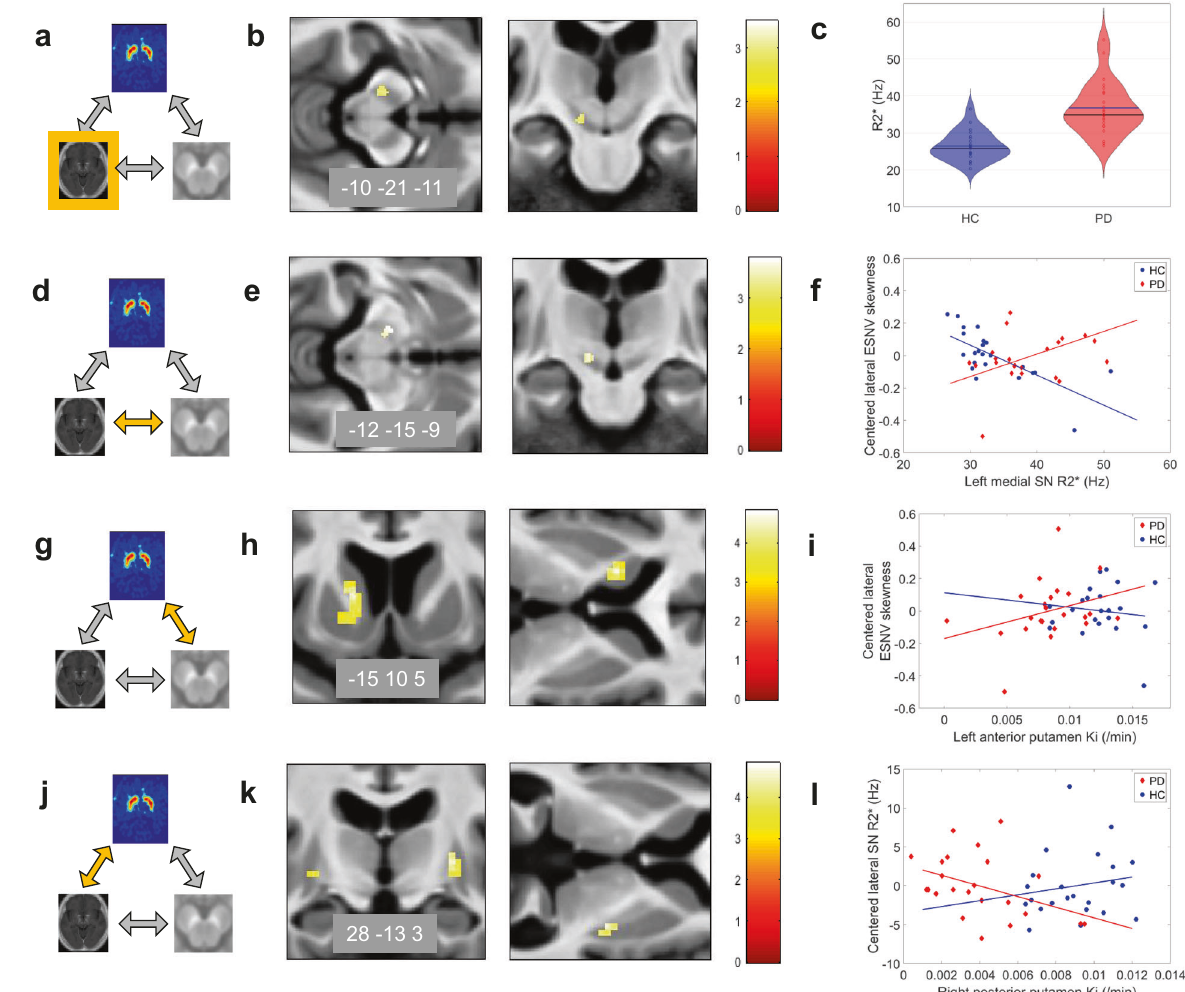
Fig. 4 Relationships between NM-sensitive MRI, R2*, and [18F]DOPA PET changes in Parkinson ’ s disease. a – c R2* changes in Parkinson ’ s disease. Main effect of disease on brain iron, as assessed by R2*, displayed at p < 0.001 uncorrected over the mean structural image of the whole population. Color scales are proportional to t values. d – f Relationship between R2* and NM-sensitive MRI data. f Peak voxel ESNV skewness in both SN increases as R2* increases in left SN, signi fi cantly more in PD patients than HC. g – i Relationship between dopaminergic neurotransmission ([18F]DOPA PET) and NM-sensitive MRI data. Regression between peak voxel in left anterior putamen Ki and bilateral SN ESNV skewness. j – l Relationship between dopaminergic neurotransmission ([18F]DOPA PET) and R2*. Peak voxel Ki values in posterior putamen regressed differentially in PD and HC with lateral SN R2*. All results are displayed at p < 0.001 uncorrected over the mean structural image of the whole population. Color scales are proportional to t